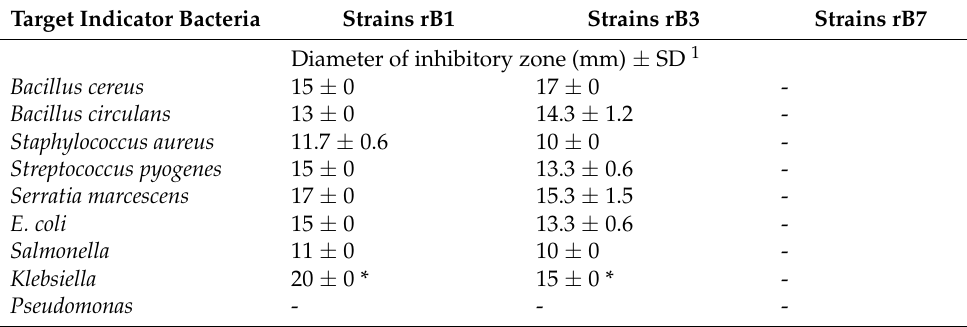
Table 4. Antimicrobial activity of BPA-tolerant human gut microbiota isolated strains. Target Indicator